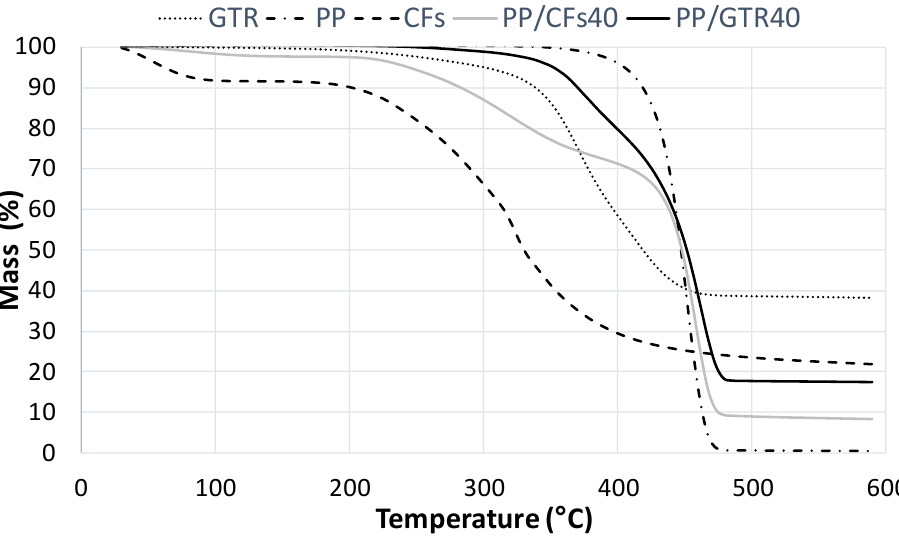
Figure 10. Thermograms of GTR/PP and CFs/PP composites at 40% composition and their corre- sponding components separately (EVA, GTR and CFs).